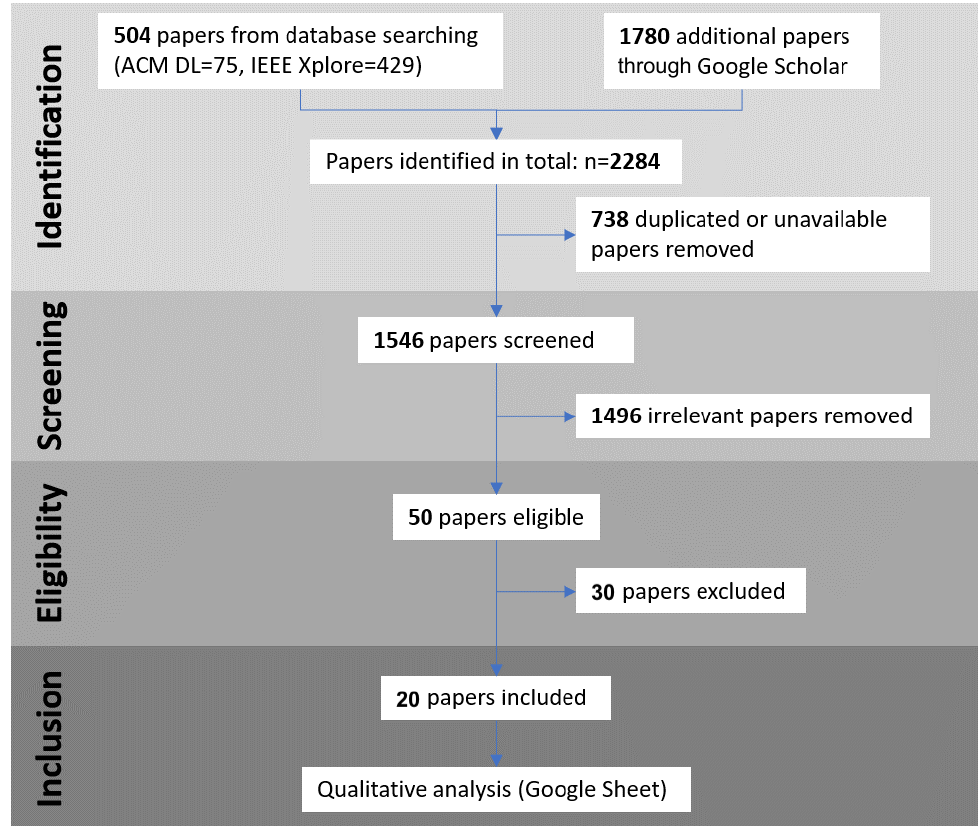
Figure 1. A flow diagram of our systematic selection process (adapted from